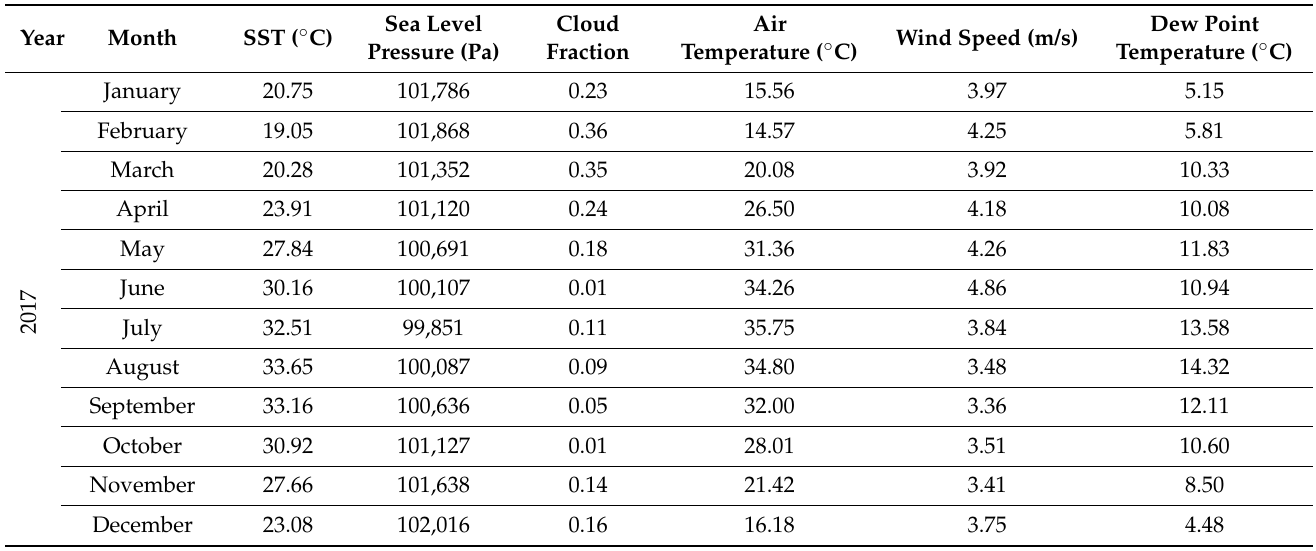
Table 2. Monthly values of meteorological